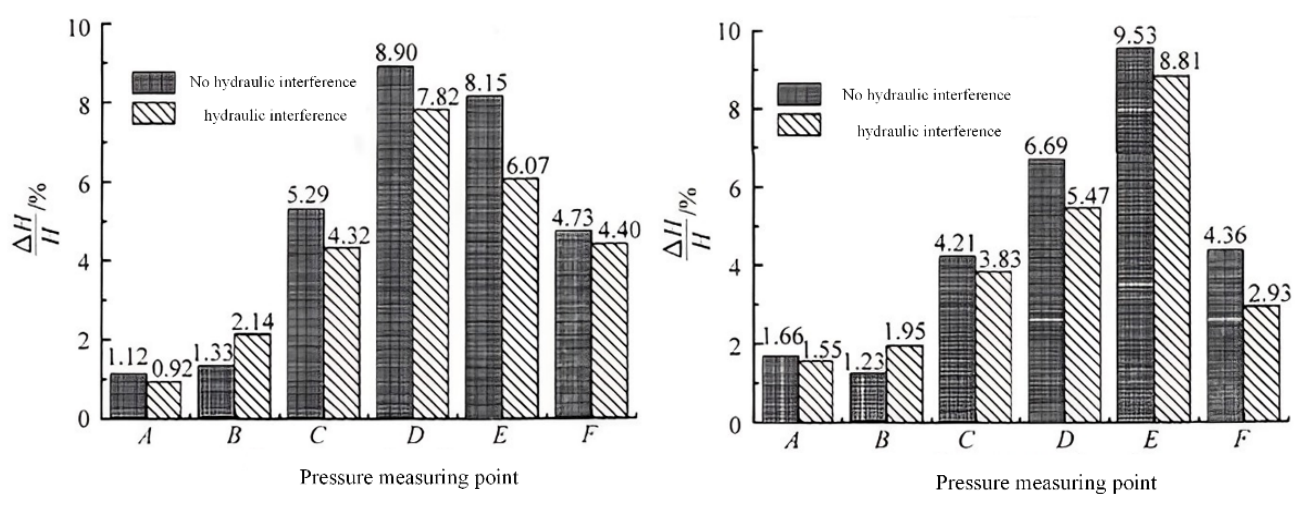
Figure 24. Peak water injection pressure with 3% Q negative circulation [39].